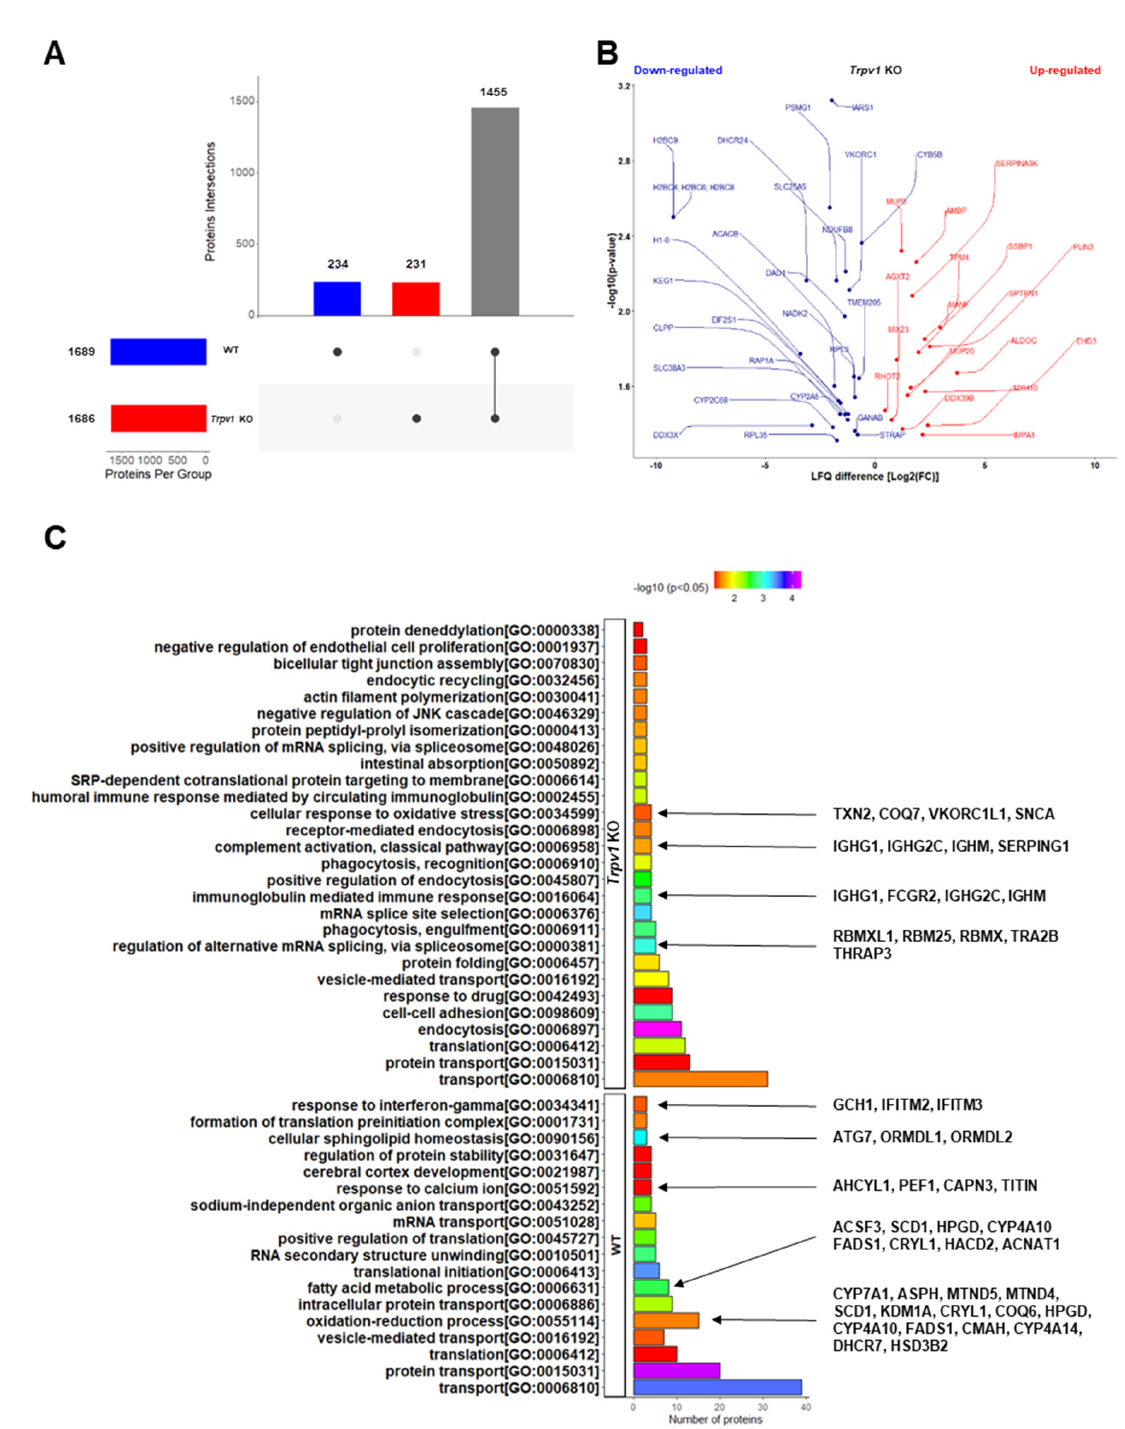
Figure 3. The lack of a TRPV1 channel affects hepatic functionality, as revealed by the integration data of liver proteomes. ( A ) The UpSet plot presents the overlapping of proteins found in the liver proteome of Trpv1 KO and WT mice. ( B ) Scatter plots show the distribution of proteins shared between liver proteomes, indicating downregulated and upregulated proteins in Trpv1 KO mice. LFQ difference denotes log2 (fold change) among groups. ( C ) Gene ontology biological process (GO-BP) enrichment analyses of differentially identified proteins in the liver proteomes using the annotation of the DAVID database ( p < 0.05) are highlighted for lipid metabolism, RNA processing, oxidative stress, and inflammation functional processes that were exclusively expressed in WT or Trpv1 KO